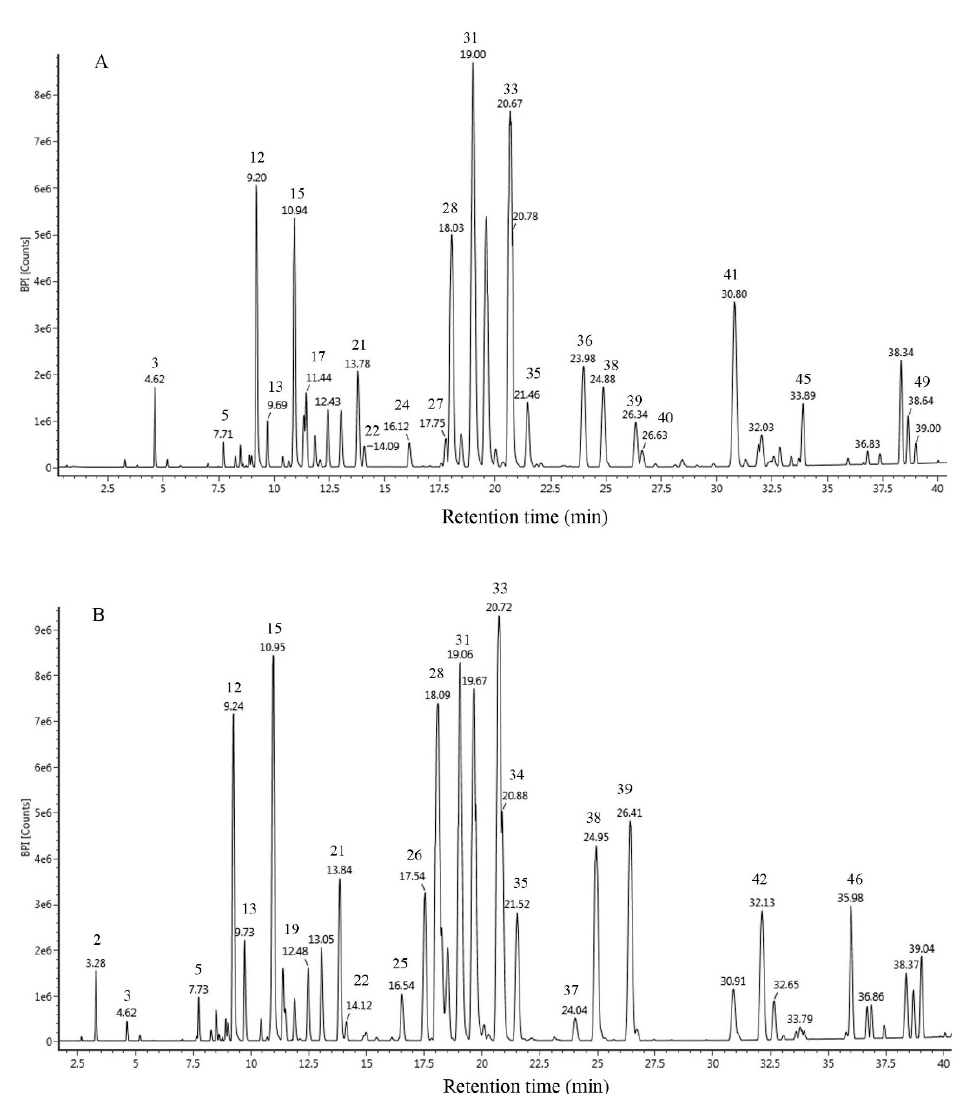
Figure 1. Chromatographic profile of propolis from the United States ( A ) and China ( B ) using UPLC-Q-TOF-MS.